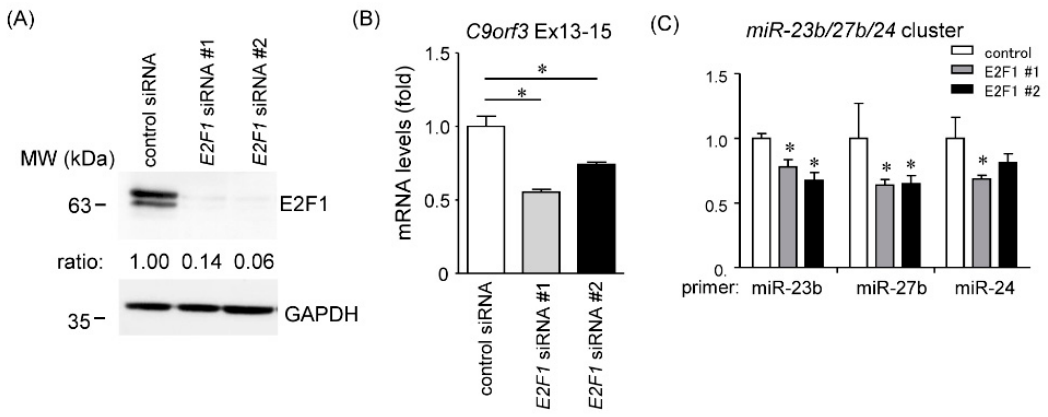
Figure 3. Knockdown of E2F1 decreased C9orf3 expression levels. ( A ) Two siRNAs targeted for distinct E2F1 sequences were transfected to the MG cells. Amounts of E2F1 proteins in E2F1 siRNAs-treated cells were measured by western blotting using GAPDH as a loading control. ( B , C ) Relative expression levels of C9orf3 and miR-23b / 27b / 24 miRNAs in MG cells after treatment with E2F1-siRNAs were measured by RT-qPCR. GAPDH or RNU48 was used as an endogenous control. Data are expressed as the mean ± standard deviation (SD; n = 4). * Statistically significant difference versus control cells (unpaired Student’s t -test, p < 0.05). MW, molecular weight.